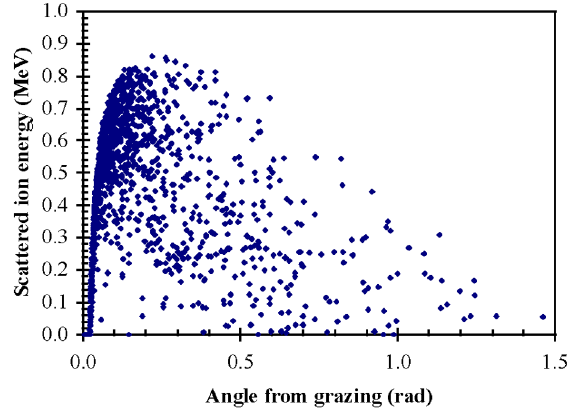
FIG. 2. (Color) Energy versus angle of the 1355 back scattered ions from 2000 1 MeV K (cid:6) ions incident on stainless steel at 88 (cid:1) from normal, computed by the SRIM code. Except for this figure, angles are shown relative to normal